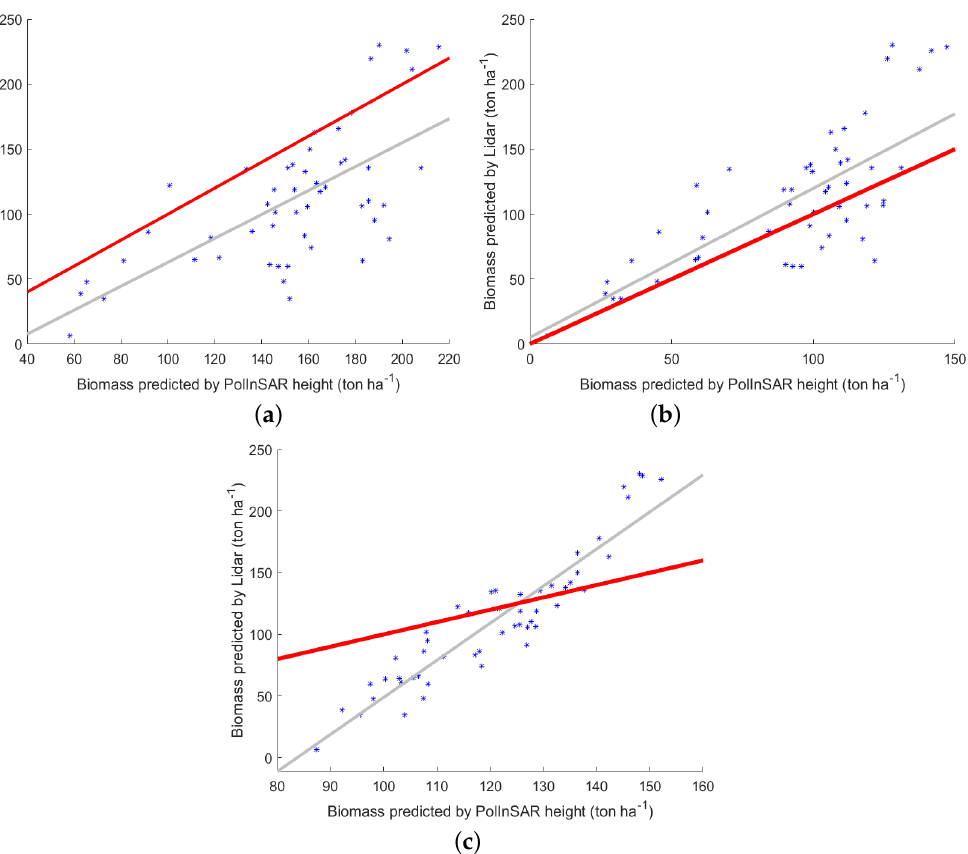
Figure 10. Relation between measured biomass by PolInSAR data and predicted biomass by Lidar data for the test dataset: ( a ) the RVoG model with R 2 = 0.60 and RMSE = 30.85 (ton ha − 1 ), ( b ) the RMoG model with R 2 = 0.73 and RMSE = 30.73 (ton ha − 1 ), and ( c ) the RMoG L model with R 2 = 0.92 and RMSE = 30.64 (ton ha − 1 ).